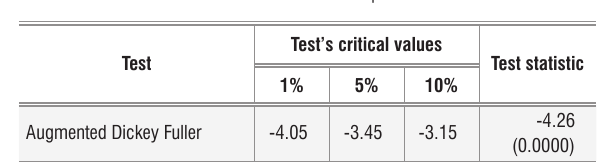
Unit root test to determine stationarity of minimum annual rainfall data for Zimbabwe for the period 1901–2009